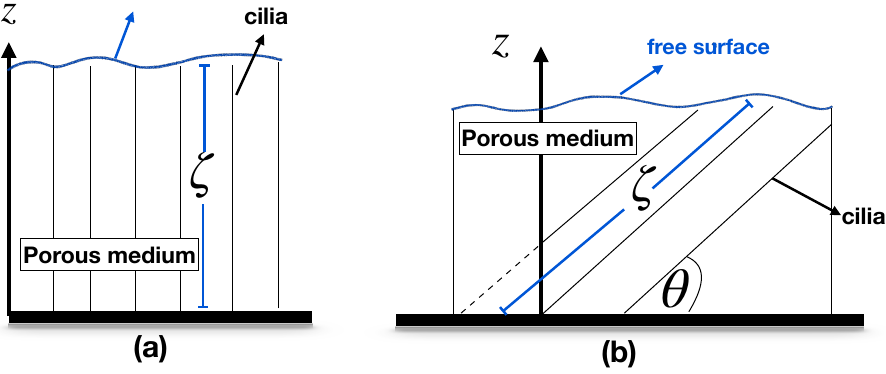
Figure 2. The free surface and the porous region on the z − axis when ( a ) the cilia are perpendicular to the horizontal plane; ( b ) the cilia make a θ angle with the horizontal